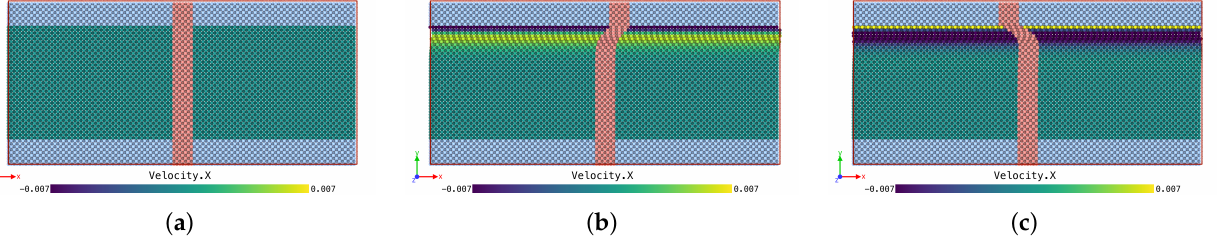
Figure 14. Set of particles tracked during the oscillatory test in a pure viscous substance. ( a ) t = 0 s. ( b ) t = 1 × 10 − 4 s. ( c ) t = 4.7 × 10 − 4 s.